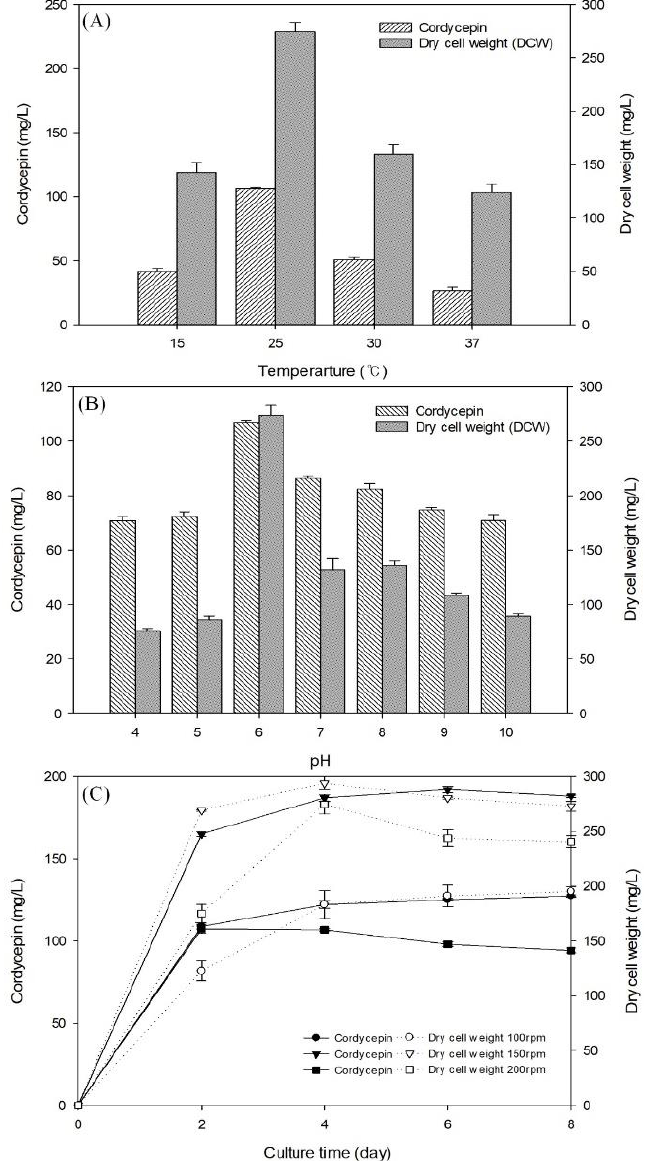
Figure 2. Effects of temperature, initial pH, and various shaking speeds on the cordycepin concentration and dry cell weight by C. militaris KYL05. ( A ) Different temperatures of 15 °C ( ○ ), 25 °C ( ▽ ), 30 °C (□), and 37 °C ( ◇ ); ( B ) initial pH of basal medium; and ( C ) different shaking speeds of 100 ( ), 150 ( (cid:72) , (cid:53) ), and 200 ( (cid:4) , (cid:3) ) rpm were used. Error bars in the figure indicate the standard derivations from three independent